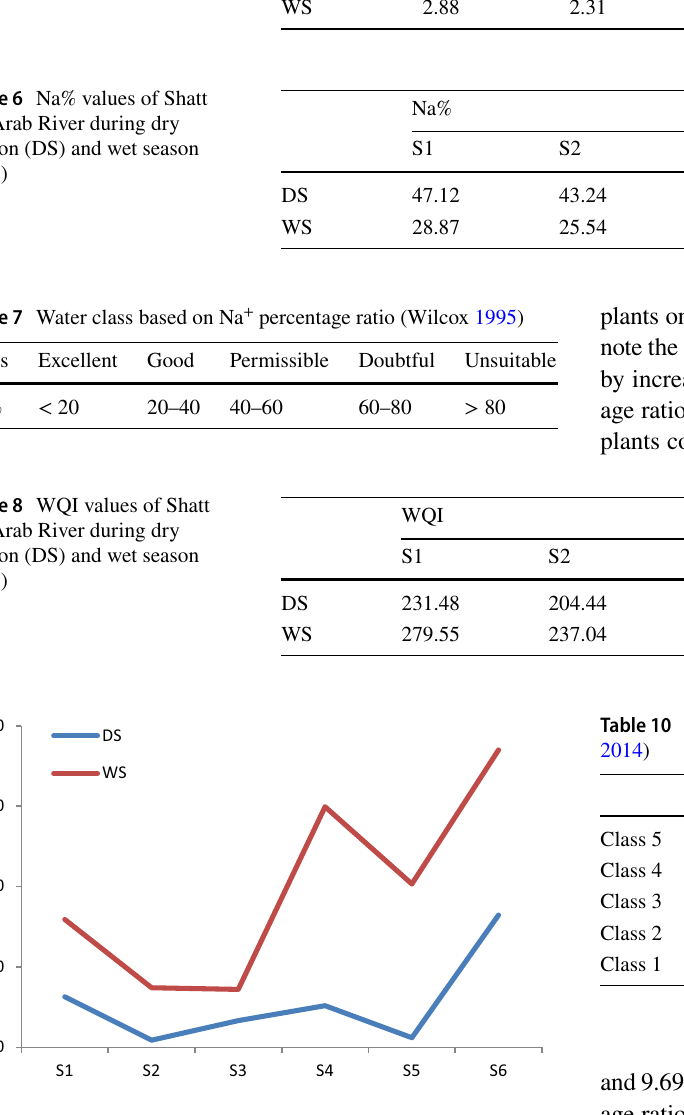
Fig. 2 Spatio-temporal variation in WQI for Shatt Al-Arab River